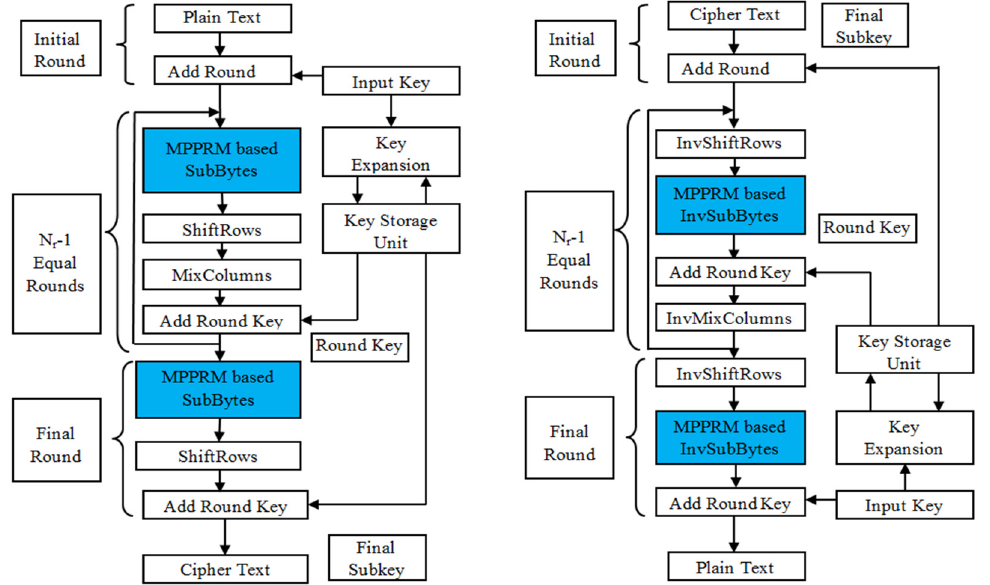
Figure 3. Description of AES-128 encryption and decryption operations.